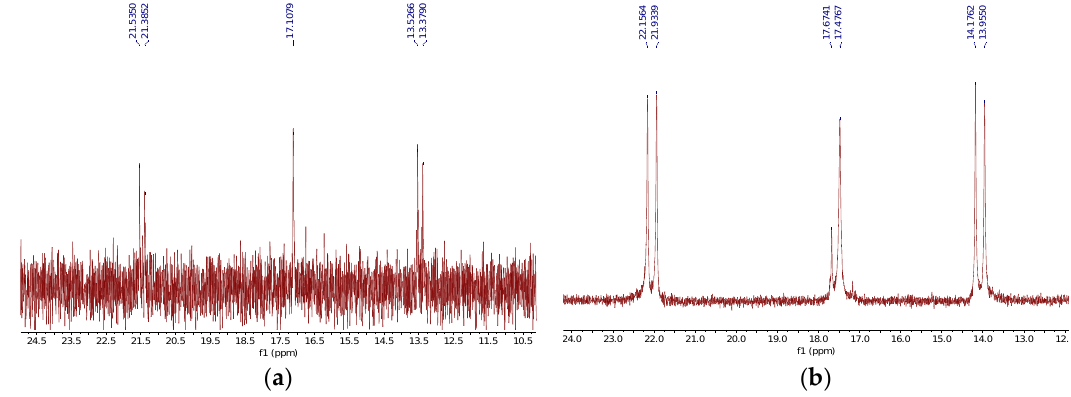
Figure 8. Phosphorus NMR spectra of 2,6 - cis -dimethylpiperaz-1,4-diylmethylenebisphosphonic acid ( cis - 14 ) ( a ) and a mixture of the cis and trans isomers ( rac - 14 ) ( b ).